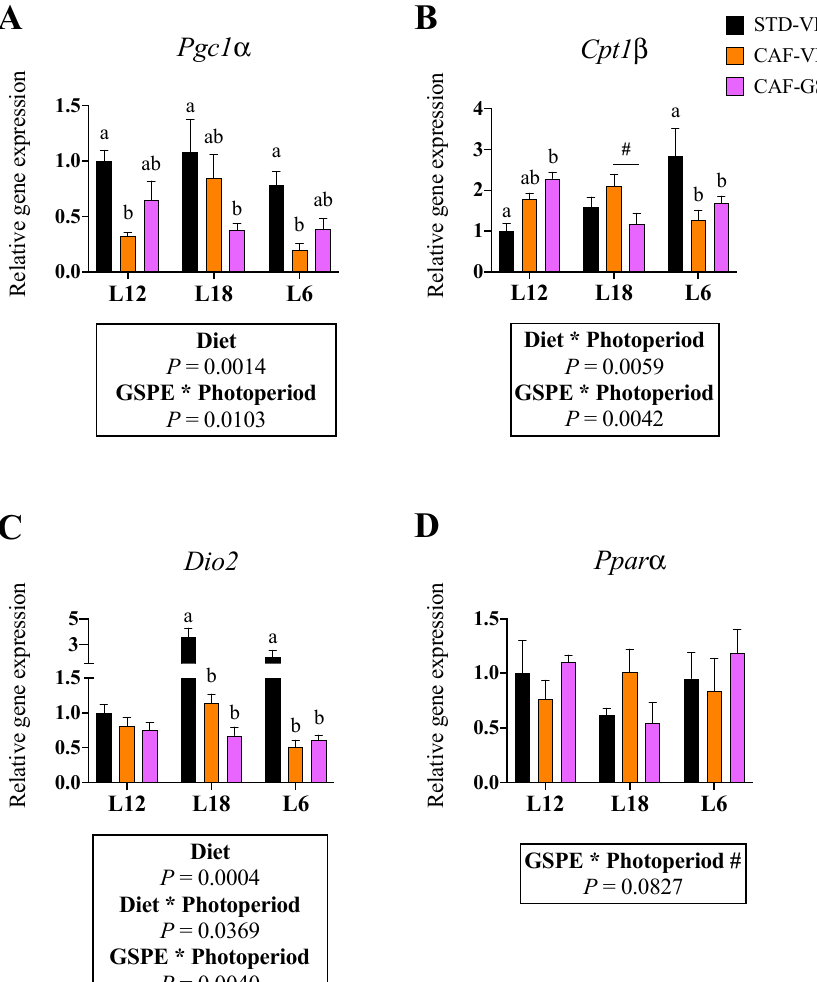
Figure 5. Effect of grape seed proanthocyanidin extract (GSPE) consumption at different photoperiods, 12 h of light:12 h of darkness (L12); 18 h of light:6 h of darkness (L18); 6 h of light:18 h of darkness (L6) on the expression of key metabolic genes in brown adipose tissue (BAT) of diet-induced obese rats. Fisher 344 rats were fed standard diet (STD) or cafeteria diet (CAF) for 9 weeks and treated with GSPE (25 mg/kg body weight) or vehicle (VH) the last 4 weeks of the study; STD-VH group; CAF-VH group; CAF-GSPE group, under different photoperiods; L12, L18 or L6. The gene expression of Pgc1 α ( A ), Cpt1 β ( B ), Dio2 ( C ) and Ppar α ( D ) was measured by qPCR and normalized by Ppia . The relative expression (presented as fold-change) of CAF-VH and CAF-GSPE was normalized to the corresponding STD-VH control group (L12 photoperiod). Significant differences were assessed through two-way ANOVA analysis ( p < 0.05). Diet: diet effect within VH groups; Diet * Photoperiod: interaction effect between diet and photoperiod within VH groups; GSPE * Photoperiod: interaction effect between GSPE consumption and photoperiod within CAF groups; #: tendency: 0.05 < p < 1. Different letters denote significant differences within each photoperiod group (assessed with two-way ANOVA followed by Tukey’s post hoc test, p < 0.05; #: tendency: 0.05 < p <